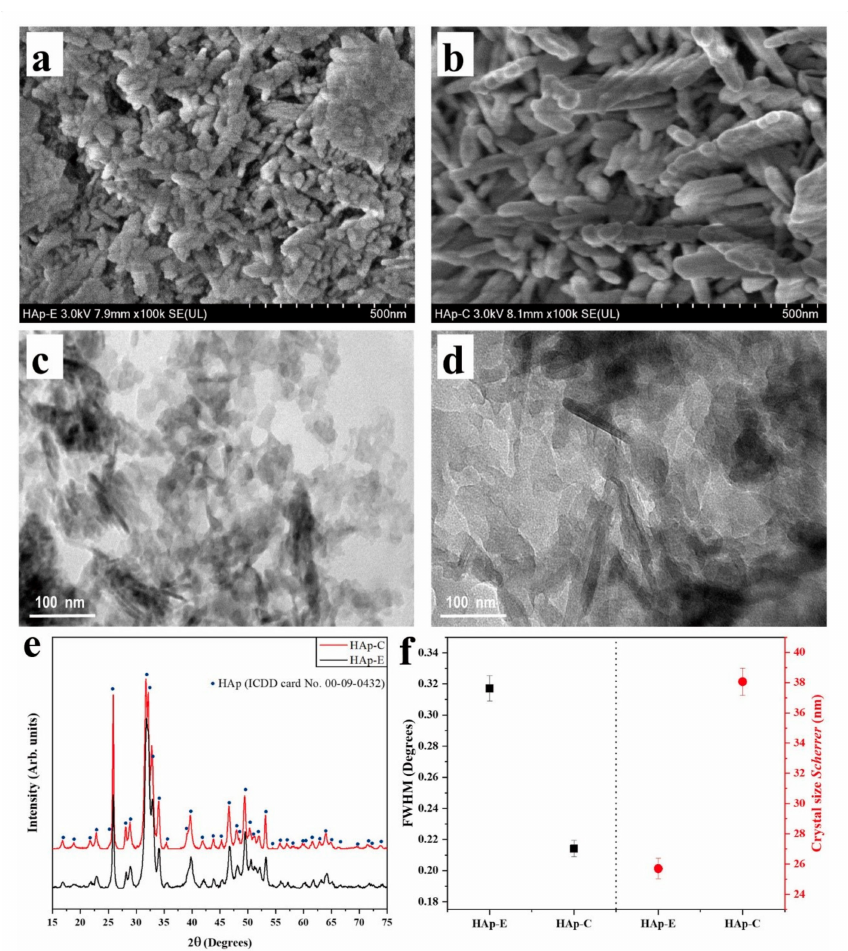
Figure 2. HR-SEM images of ( a ) HAp-E and ( b ) HAp-C at 100,000 × . HR-TEM images of ( c ) HAp-E and ( d ) HAp-C at 100,000 × . X-ray diffraction patterns of ( e ) HAp-E and HAp-C. ( f ) FWHM and crys- tal size by Scherrer’s equation [42]. Reproduced with permission from copyright © 2022,